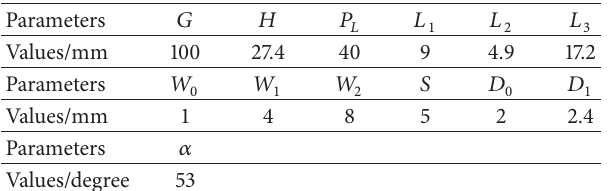
Table 1: Dimensions of the proposed